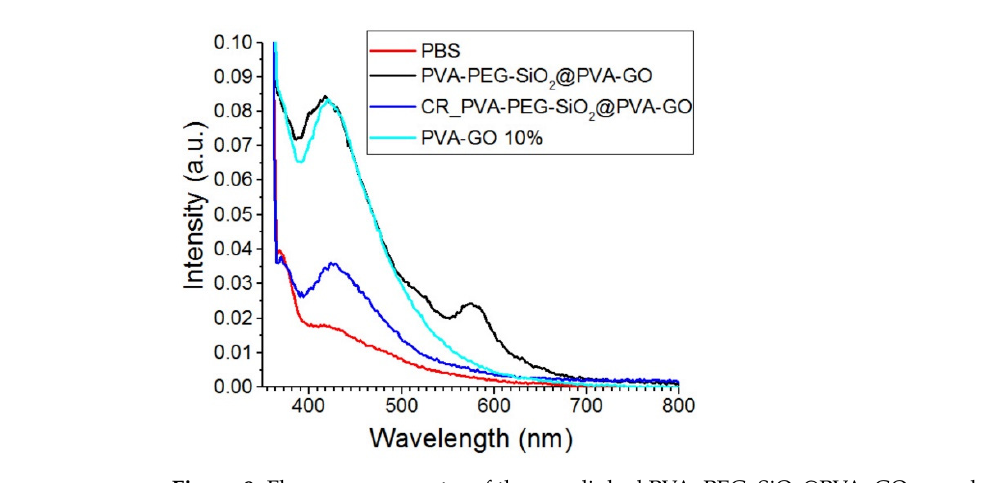
Figure 9. Fluorescence spectra of the crosslinked PVA–PEG–SiO 2 @PVA–GO core-shell composite and shell PVA–GO fibers excited at 330 nm.